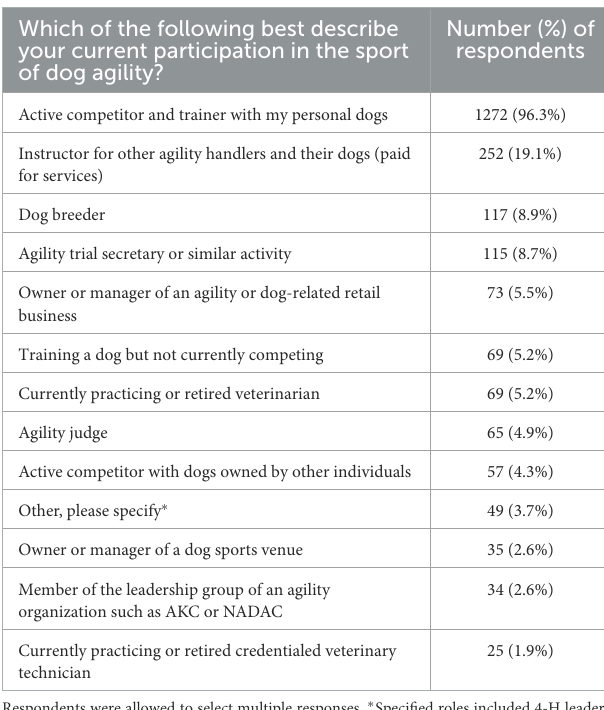
TABLE 3 Number (%) of 1,321 respondents indicating the specified type of participation in canine